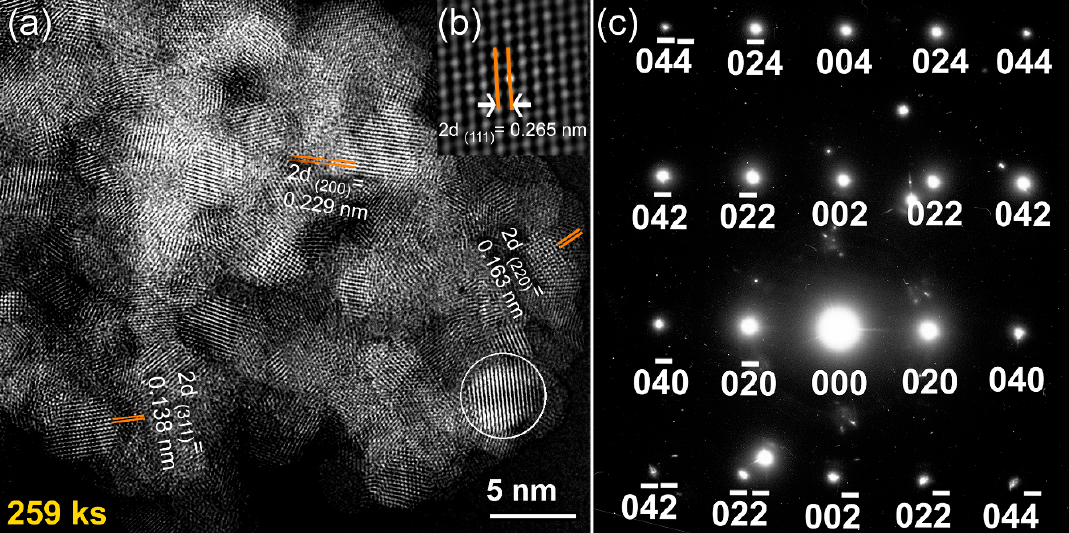
Figure 4. ( a , b ) FE-HRTEM dark field (DF) images; ( c ) the corresponding nanobeam diffraction patterns (NBDP) pattern of ZrN powders obtained after 259 ks of the RBM time.